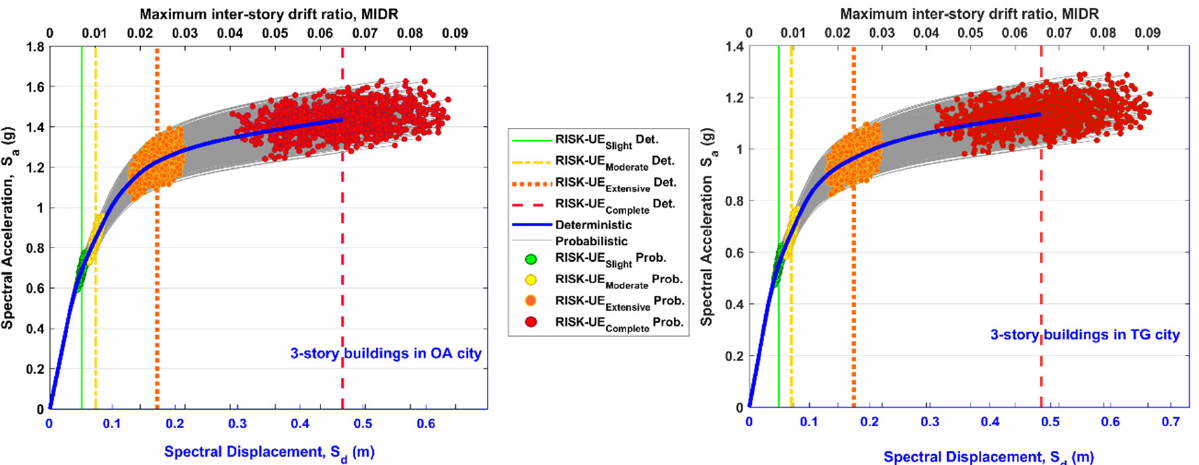
Figure 5. Deterministic and probabilistic capacity spectra of the 3-story buildings in OA and TG cities and their respective DS non-null .